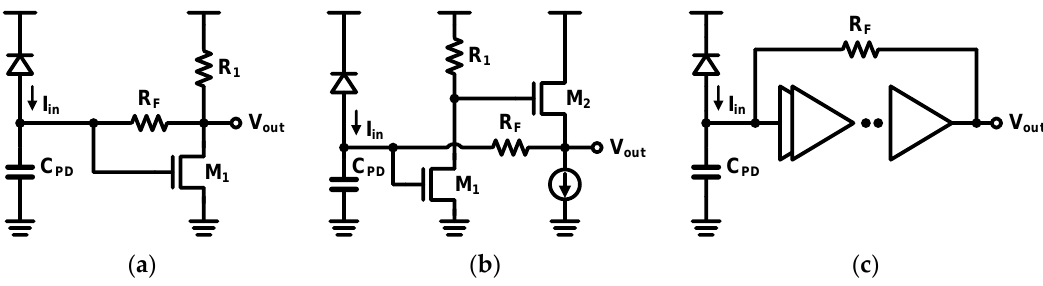
Figure 26. Various implementations of shunt-shunt feedback TIA. ( a ) CS amplifier with resistor feedback, ( b ) Cascaded CS amplifier and source follower with resistor feedback, and ( c ) multi-stage amplifier with resistor feedback.